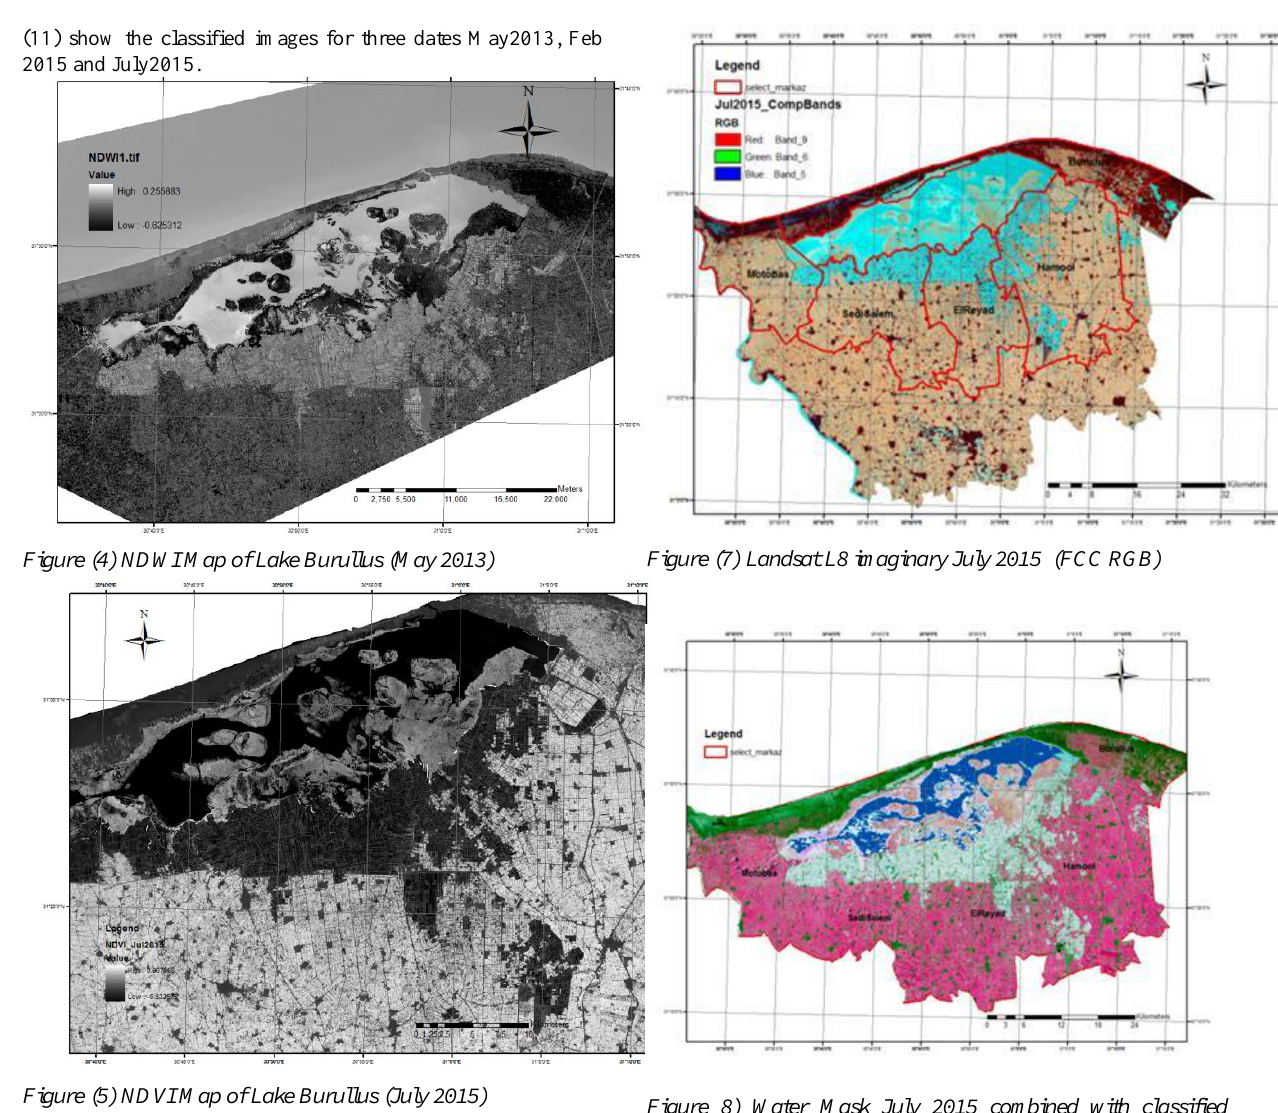
Figure 8) Water Mask July 2015 combined with classified